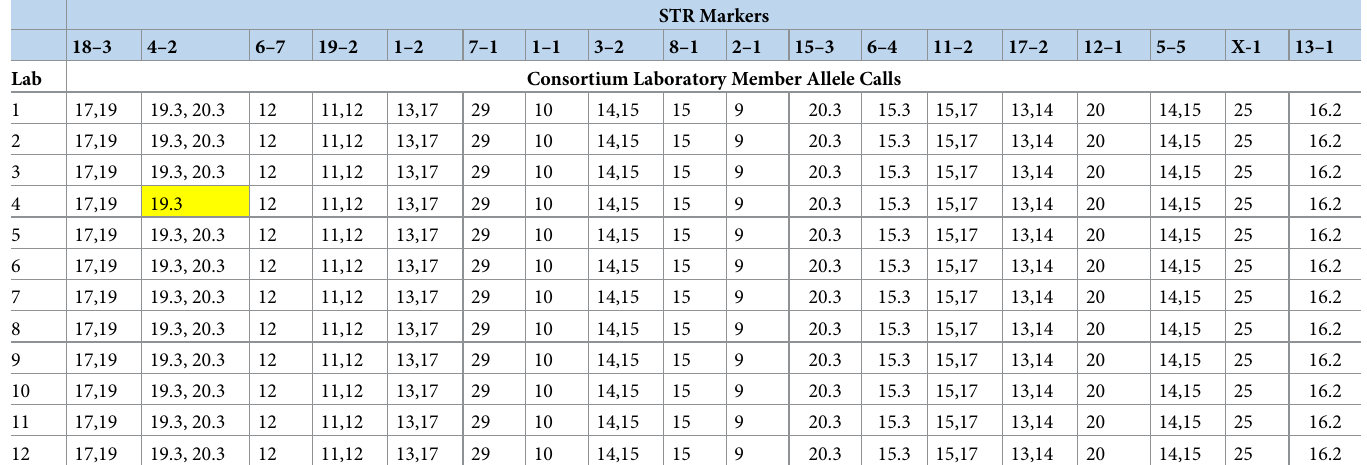
With the removal of STR marker 11–1, the Consortium laboratory members had concor- dant STR profiles for 21 of the 50 cell lines tested (see Table 6). Allele calls for these 21 cell lines were in full concordance among the Consortium laboratory members at 18 STR loci. Although the remaining 29 cell lines were discordant, the percent of accurately calling alleles among the Consortium laboratory members were above 92% for all cell lines. Each dis- cordant cell line is summarized with an average percent allele agreement, the corresponding number of STR markers that were discordant, and the reasons for discordance (Table 7). Cell lines that require further